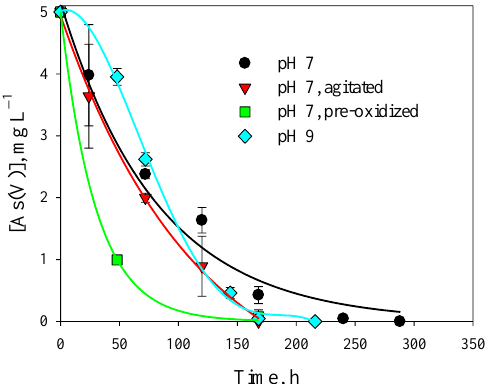
Figure 3. Temporal profiles of As(V) concentration using µ Fe(0). Conditions: [As(V)] 0 = 5 mg L − 1 , [ µ Fe(0)] = 0.25 g L − 1 , RT, EC = 0.03 mS cm − 1 , pH 7 or 0.25 mS cm − 1 , pH 9, no agitation unless indicated. Error bars represent the standard deviation between duplicates. The black and green lines are fittings to Equation (3), while red and cyan lines are only for visualization and do not correspond to any fitting model.